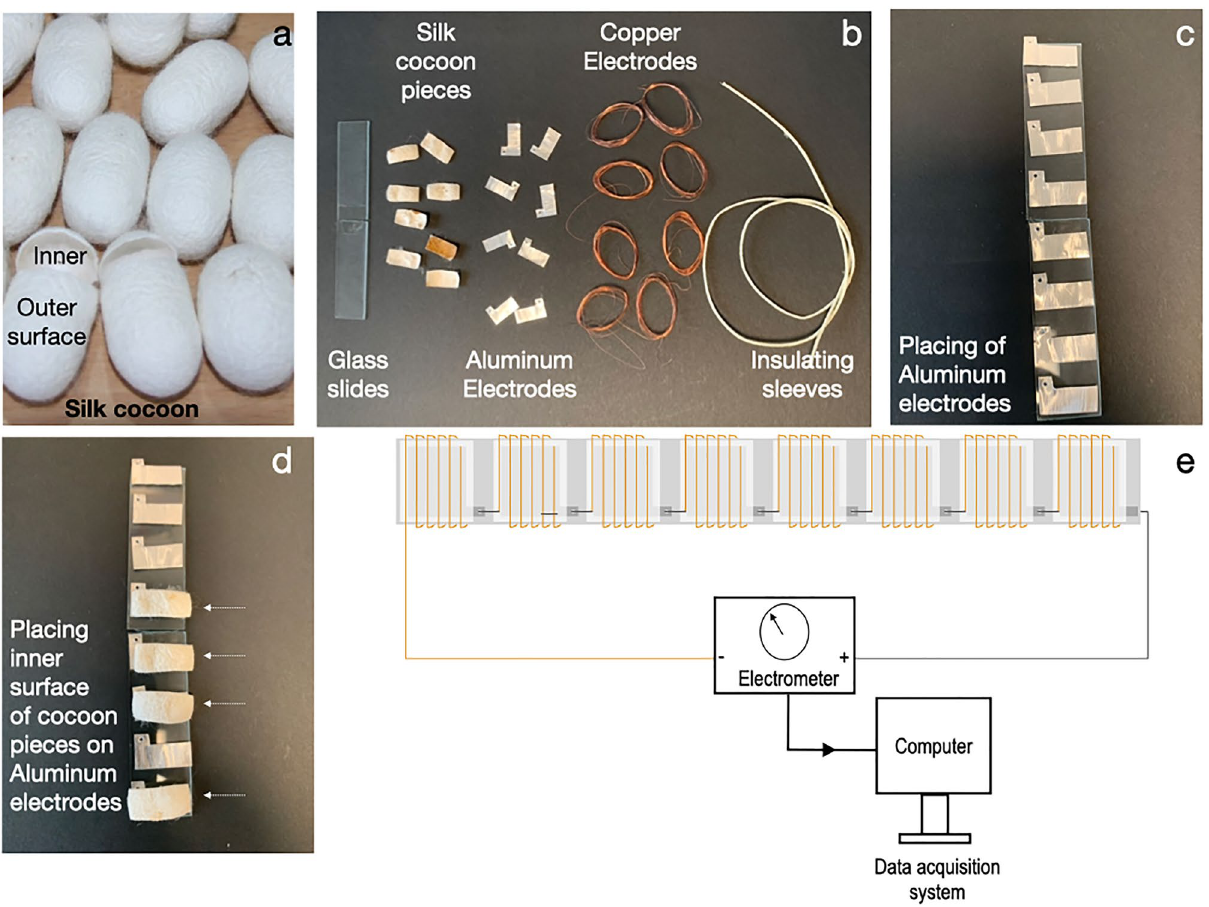
Figure 1. Materials for silk cocoon biobattery. ( a ) Raw Bombyx mori silk cocoons. Cut open the cocoon showing the inner and outer surface of the cocoon with a distinctly different texture. ( b ) All the components for silk cocoon battery. Two glass slides glued together. Silk cocoon pieces with a dimension of 1.1 cm * 2.5 cm. 32 Gauge aluminium electrode cut from aluminium sheet. High purity 1.12 m copper wires (32 AWG) for copper electrodes. Insulating sleeves. ( c ) Placing the aluminium electrodes on the glass slide. ( d ) Placing the inner surface of cocoon pieces facing the aluminium electrode (shown in dotted arrows). ( e ) The device